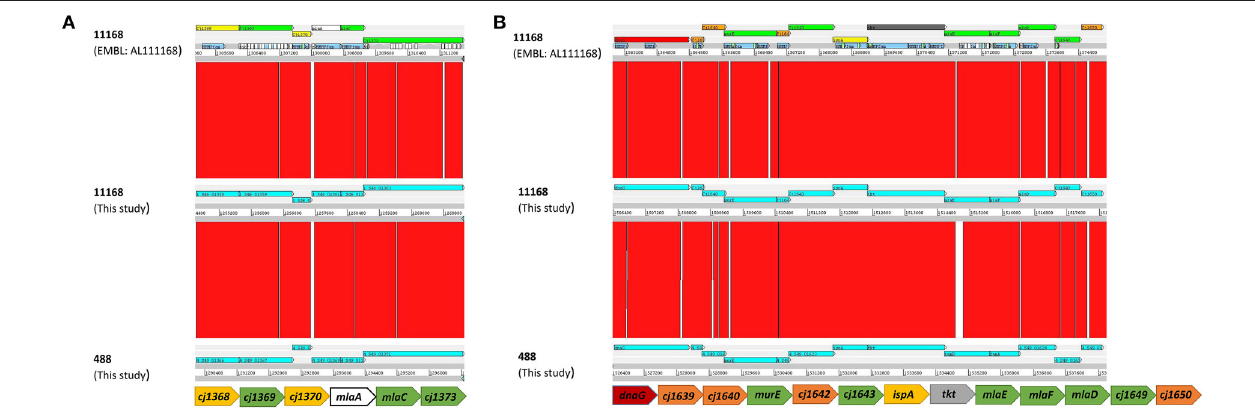
FIGURE 1 | Comparison using the Artemis Comparison Tool (ACT) (Carver et al., 2005) software of the gene clusters containing (A) mlaAC and (B) mlaEDF using the C. jejuni 11168 original genome sequenced strain from the Sanger public database (ID CJ11168 accession number AL111168) and the new sequences of the 11168 and 488 wild-type strains produced here. Below each ACT window is the conserved organization of the mla gene clusters for the strains used in this study based on synteny between the annotated AL111168 genome sequence and the newly sequenced strains in this study. The color qualifier for annotated gene sequences was based on gene function following the scheme adopted by the Wellcome Trust Sanger Institute Pathogen Genomic Department. Functional colors included in this figure are: yellow (central/intermediary/miscellaneous metabolism); dark green (surface–IM, OM, secreted, surface structures); white (pathogenicity/Adaptation/Chaperones); red (information transfer–transcription/translation + DNA/RNA modification); orange (conserved hypothetical), and dark gray (energy metabolism).